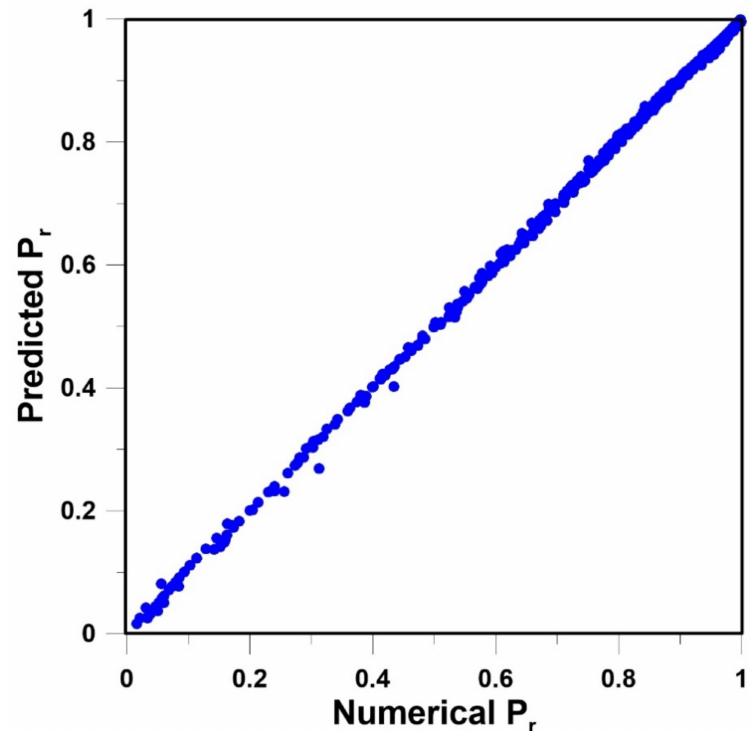
Figure 6. Parity plot of the predicted P r and the numerically-determined P r for the feedforward neural network (FFNN) of Figure 5 with six hidden neurons, including the